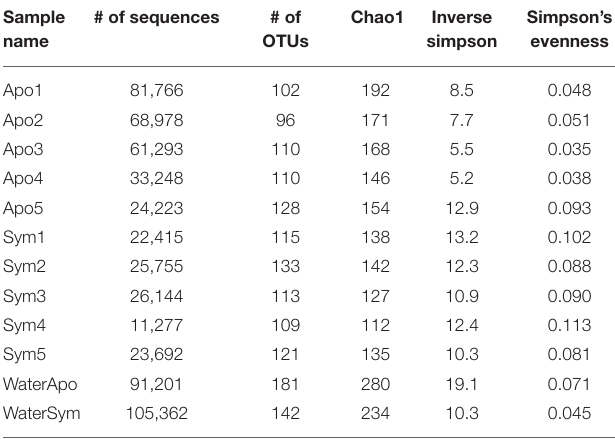
TABLE 1 | Summary statistics of 16S rRNA gene bacterial community sequencing of Aiptasia .